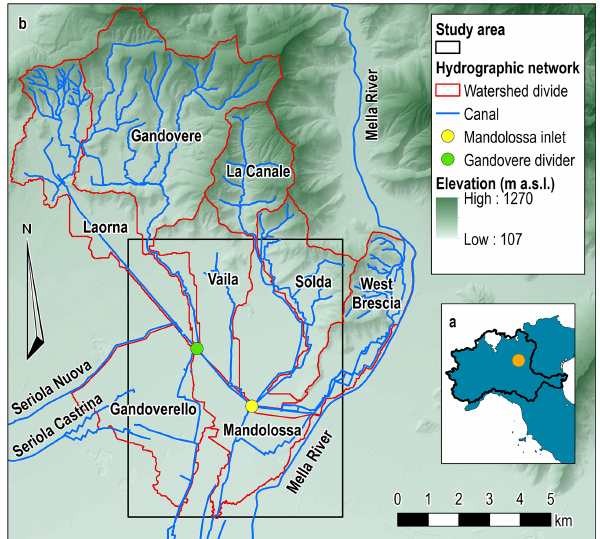
Figure 1. Location of the study area with respect to the Po river valley in northern Italy (a) and main hydrographic features of the foothill area west of the town of Brescia (b) ; base map 5m Dig- ital Elevation Model provided by Lombardy Region